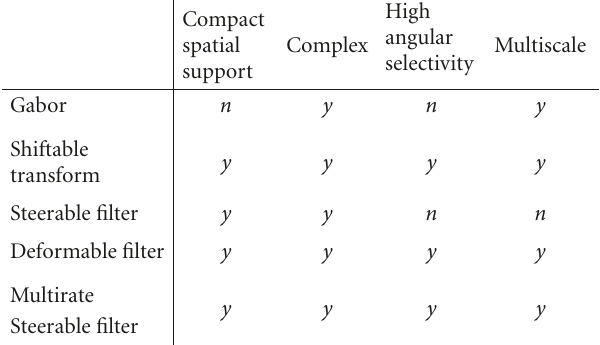
Table 2: Characteristics of signal processing